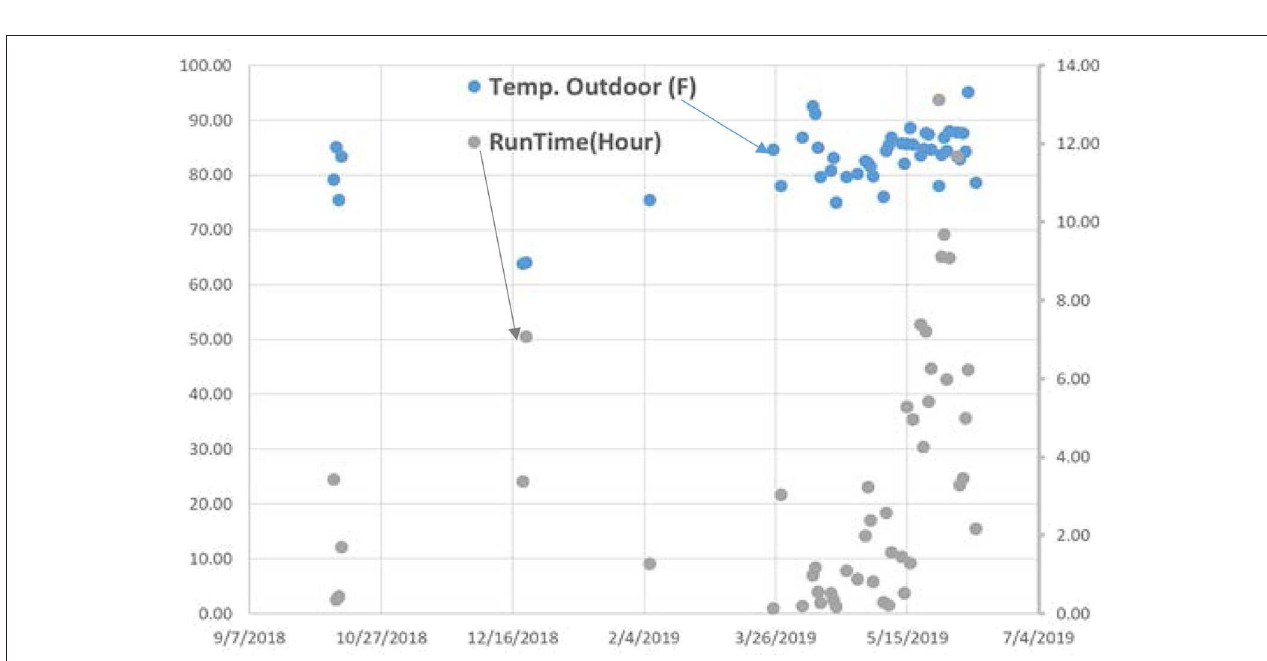
FIGURE 11 | The HVAC system planned to be used in the experimental validation of the new comfort controller will be heavily instrumented so its operation can be integrated and controlled by the new comfort controller.